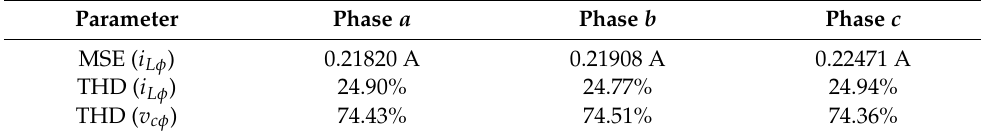
Table 11. Experimental for FCS-MPC results in steady-state conditions.